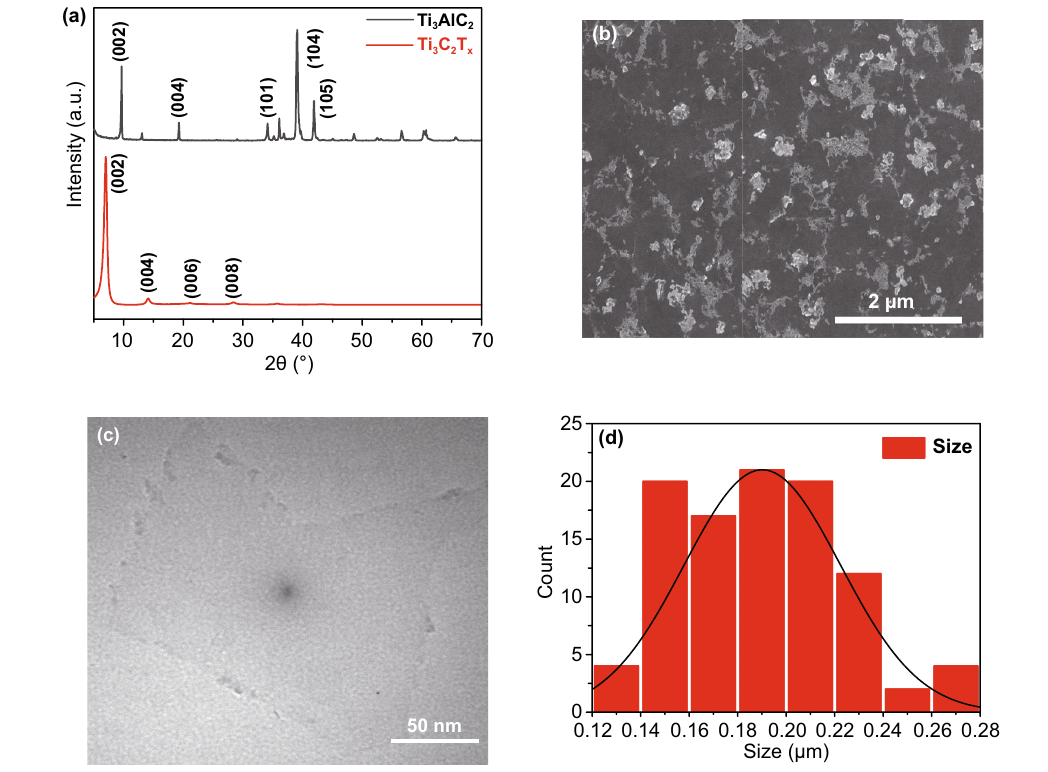
Fig. 1 a XRD patterns of raw Ti 3 AlC 2 powder and Ti 3 C 2 T x nanosheets. b SEM and c TEM images of monolayer Ti 3 C 2 T x nanosheets after soni‑ cation. d Particle size statistics for monolayer Ti 3 C 2 T x nanosheets after